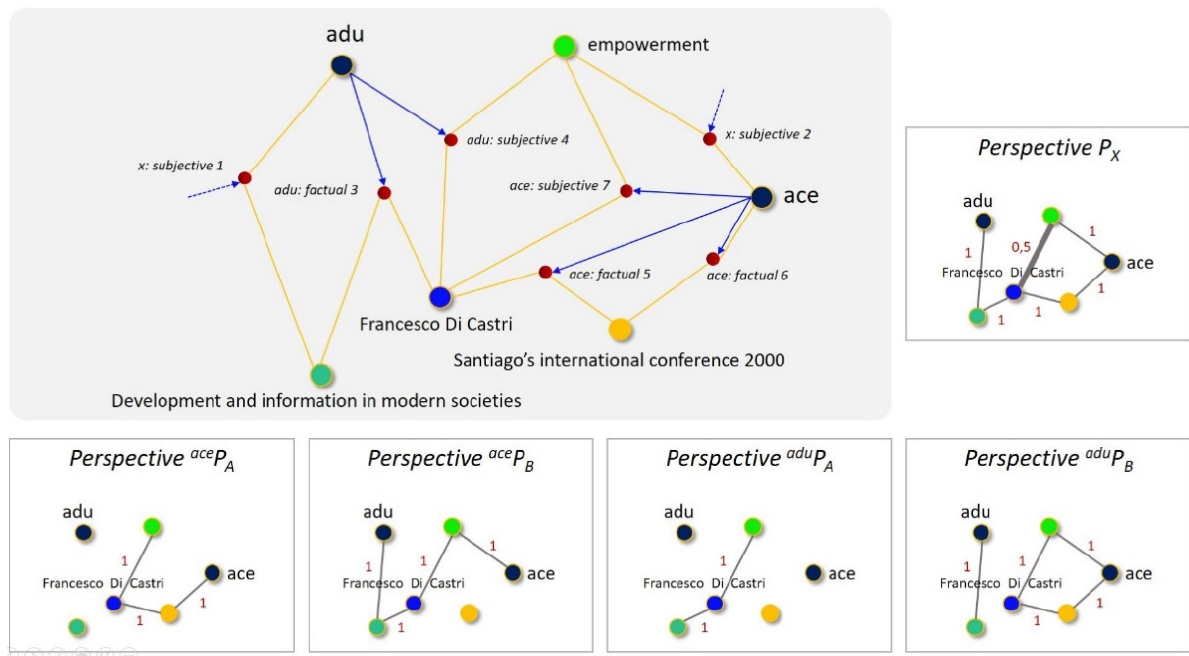
Figure 6. How the dynamics of the community and the chosen perspectives both influence the connectivity and the distances between resources in the KMs.